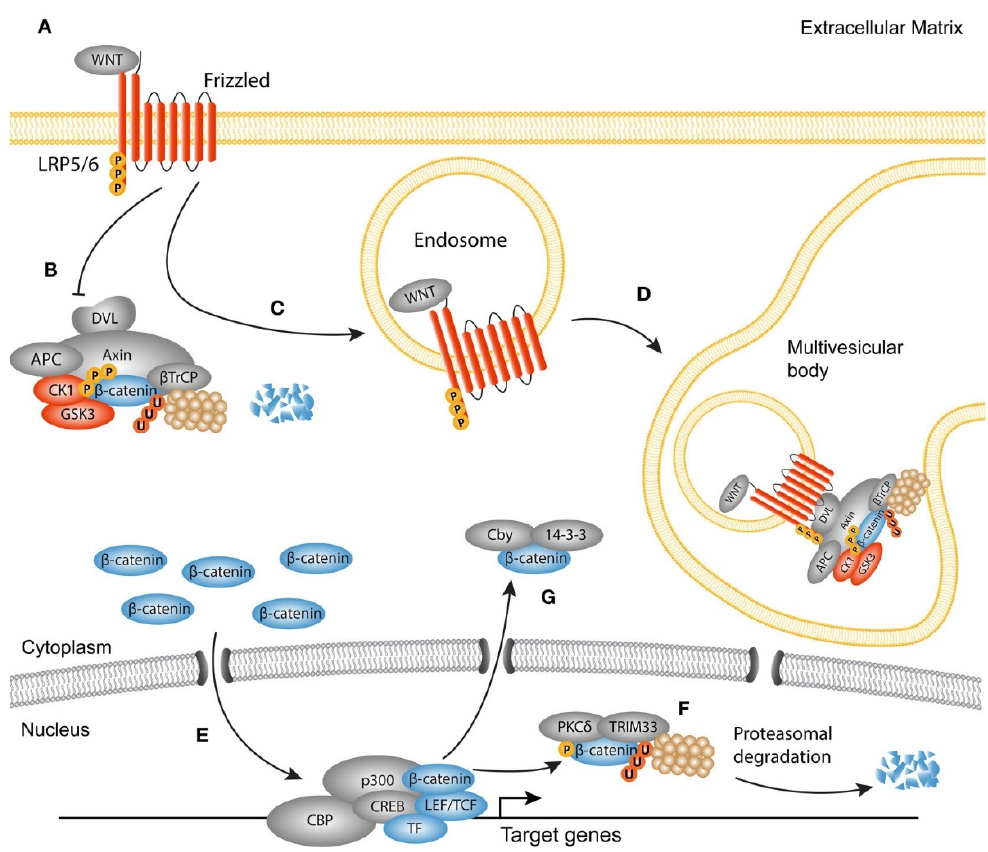
Figure 2. Schematic illustration representing the role of Wnt/ β -catenin signaling pathway in fibrosis. ( A ) shows the binding of Wnt to the frizzled receptor that forms a complex with LRP. ( B ) shows the ubiquitination of the degeneration complex composed of DVL, Axin, APC, GSK3, and CK1. ( C ) shows the internalization of the receptor complex into the endosomal vesicles that causes the sequestration of the degeneration complex and suppression of GSK3. ( D ) GSK3 is then transferred to MVB and protects cytoplasmic β -catenin against proteasome degradation. In section ( E ), β -catenin is then carried to the nucleus and interacts with various transcription proteins such as LEF/TCF, p300, and CBP. ( F ) shows the termination of the signaling pathway. PKC-6 phosphorylates the β -catenin, making it a target for ubiquitination with (TRIM)33. Then, the ubiquitinated β -catenin is degraded in the proteasome complex. ( G ) Wnt/ β -catenin signaling pathway may also end with 14-3-3 ζ and Chibby (Cby). Abbreviations: Lipoprotein-related-receptor protein (LRP), dishevelled (DVL), adenomatous polyposis coli (APC), glycogen synthase kinase 3 (GSK3), and casein kinase 1(CK1), T cell factor/lymphoid enhancer factor family (LEF/TCF), protein kinase C (PKC) δ , tripartite motif (TRIM)33, CREB-binding protein (CBP). Adopted from reference [99].